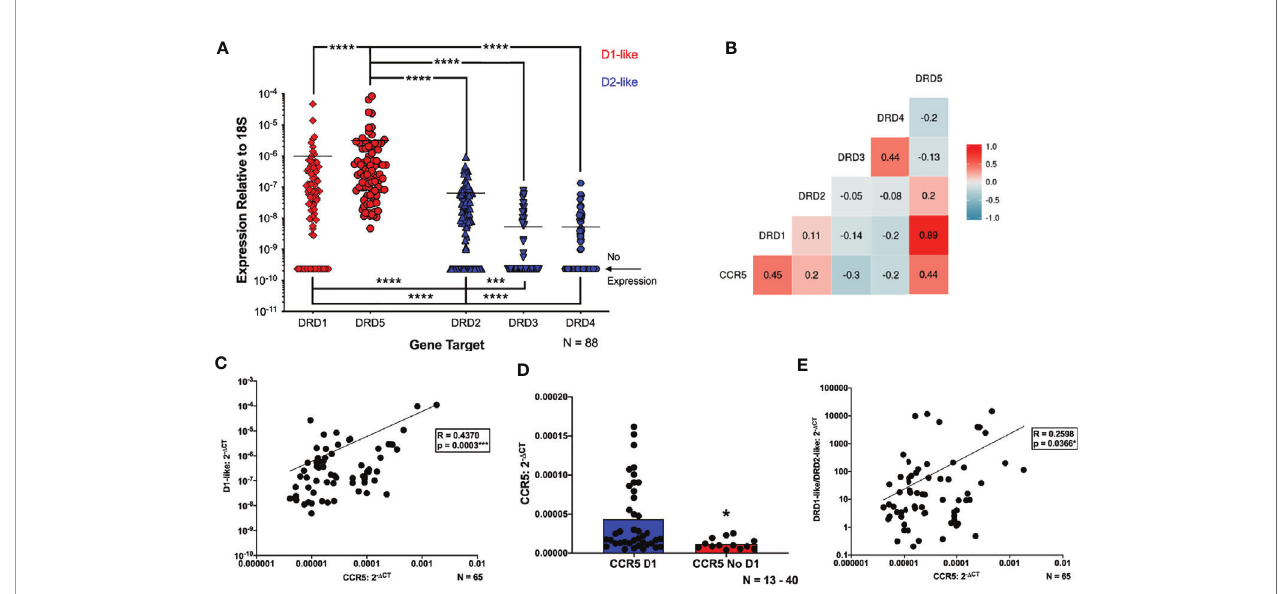
FIGURE 2 | Expression of CCR5 correlates with dopamine receptor expression in hMDM. (A) Quantitative RT-PCR detected mRNA for all subtypes of dopamine receptors (D1R, D2R, D3R, D4R and D5R) in primary human monocyte-derived macrophages (hMDM) (N=88). Expression of all receptors was normalized to 18s for each donor. The D1-like receptors (red dots) were expressed at signi fi cantly higher levels than the D2-like receptors (blue dots) (Friedman test, n=88, Friedman statistic 233, ****p < 0.0001; Post-hoc with Dunn ’ s multiple comparisons, DRD5 vs. DRD1, DRD2, DRD3, or DRD4 ****p < 0.0001, DRD1 vs. DRD3 or DRD4, ****p < 0.0001, DRD2 vs. DRD3, ***p = 0.0003, and DRD2 vs. DRD4, ****p < 0.0001). Correlational analyses were then performed to look at correlations between each dopamine receptor and CCR5 mRNA expression (N=65). A matrix to visualize these correlations is shown in (B) , and we found that increased expression of CCR5 is associated with greater expression of the D1-like receptors (CCR5 vs D1, n = 65, Spearman r = 0.4454, ***p = 0.0002, CCR5 vs D5, n = 65, Spearman r = 0.4448, ***p = 0.0002). Increased expression of CCR5 is also associated with decreased DRD3 expression (CCR5 vs D3, n = 65, Spearman r = -0.3007, *p = 0.0149), and no association was found between the other D2-like receptors and CCR5. A number of donors lacked expression of one or more dopamine receptors, so the data were reanalyzed for correlations between CCR5 and the (C) D1-like (DRD1 and DRD5) dopamine receptors. These analyses showed a positive correlation between CCR5 and D1-like receptors (CCR5 vs D1-like dopamine receptors, n = 65, Spearman r = 0.4370, ***p = 0.0003). The connection between D1- like receptors and CCR5 was strengthened by analysis of CCR5 levels in hMDM that did or did not express DRD1. These analyses showed hMDM without DRD1 had signi fi cantly lower levels of CCR5 mRNA than those expressing DRD1 (Mann-Whitney test, n = 17 - 48, *p = 0.0218, sum of (D1, No D1) ranks 1737, 408, U=255) (D) . This was not done for DRD5 because all donors expressed this receptor. CCR5 levels were also correlated with a D1-like receptor/D2-like receptor ratio (D1/D2 ratio) (E) , and we showed a signi fi cant, positive correlation between the D1/D2 ratio and CCR5 expression (CCR5 vs D1/D2-like dopamine receptors, n = 65, Spearman r = 0.2598, *p =